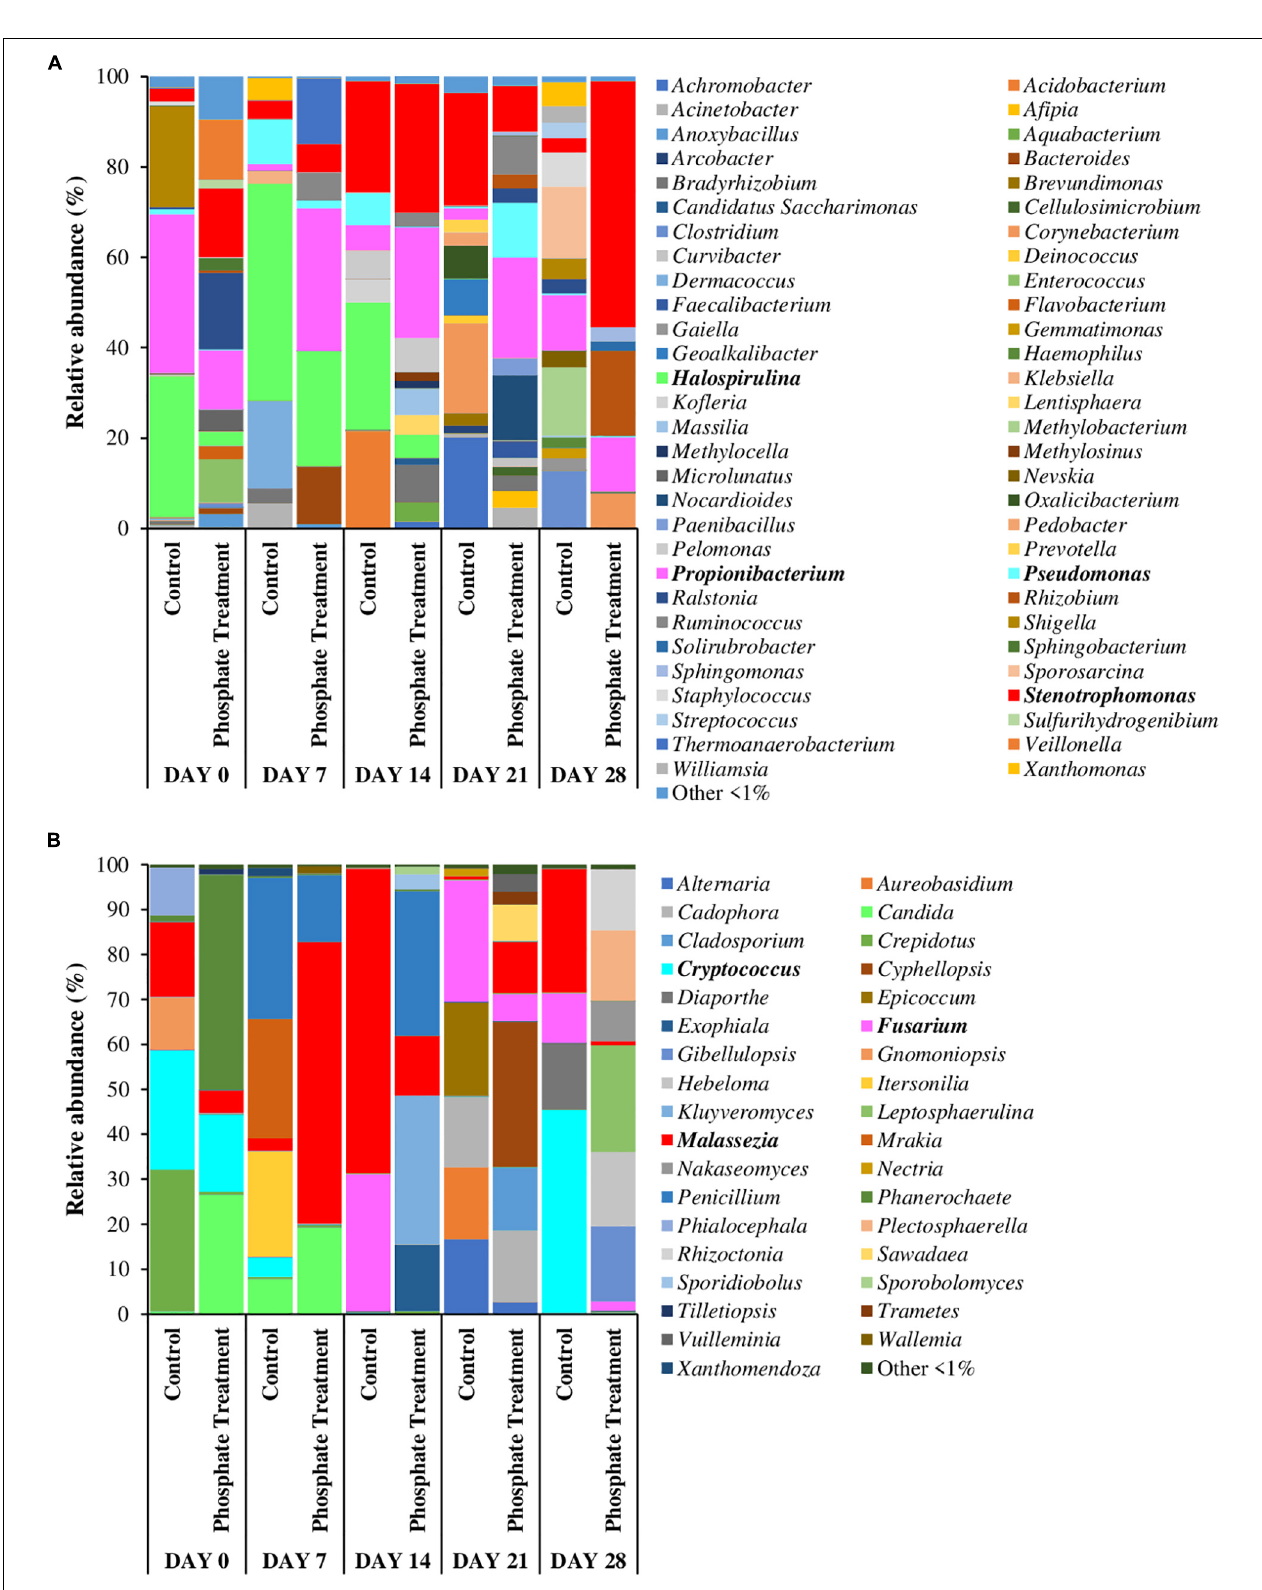
FIGURE 4 | Relative abundance of most abundant bacterial (A) and fungal (B) genera. Average of relative abundance of the most abundant fungal genera ( n = 3) in different sampling time (0,7, 14, 21, and 28 days) of different treatments (phosphate treatment and control) belonging to biofilm coupons samples. The most abundant genera are those which have a relative abundance up to 1% in all the